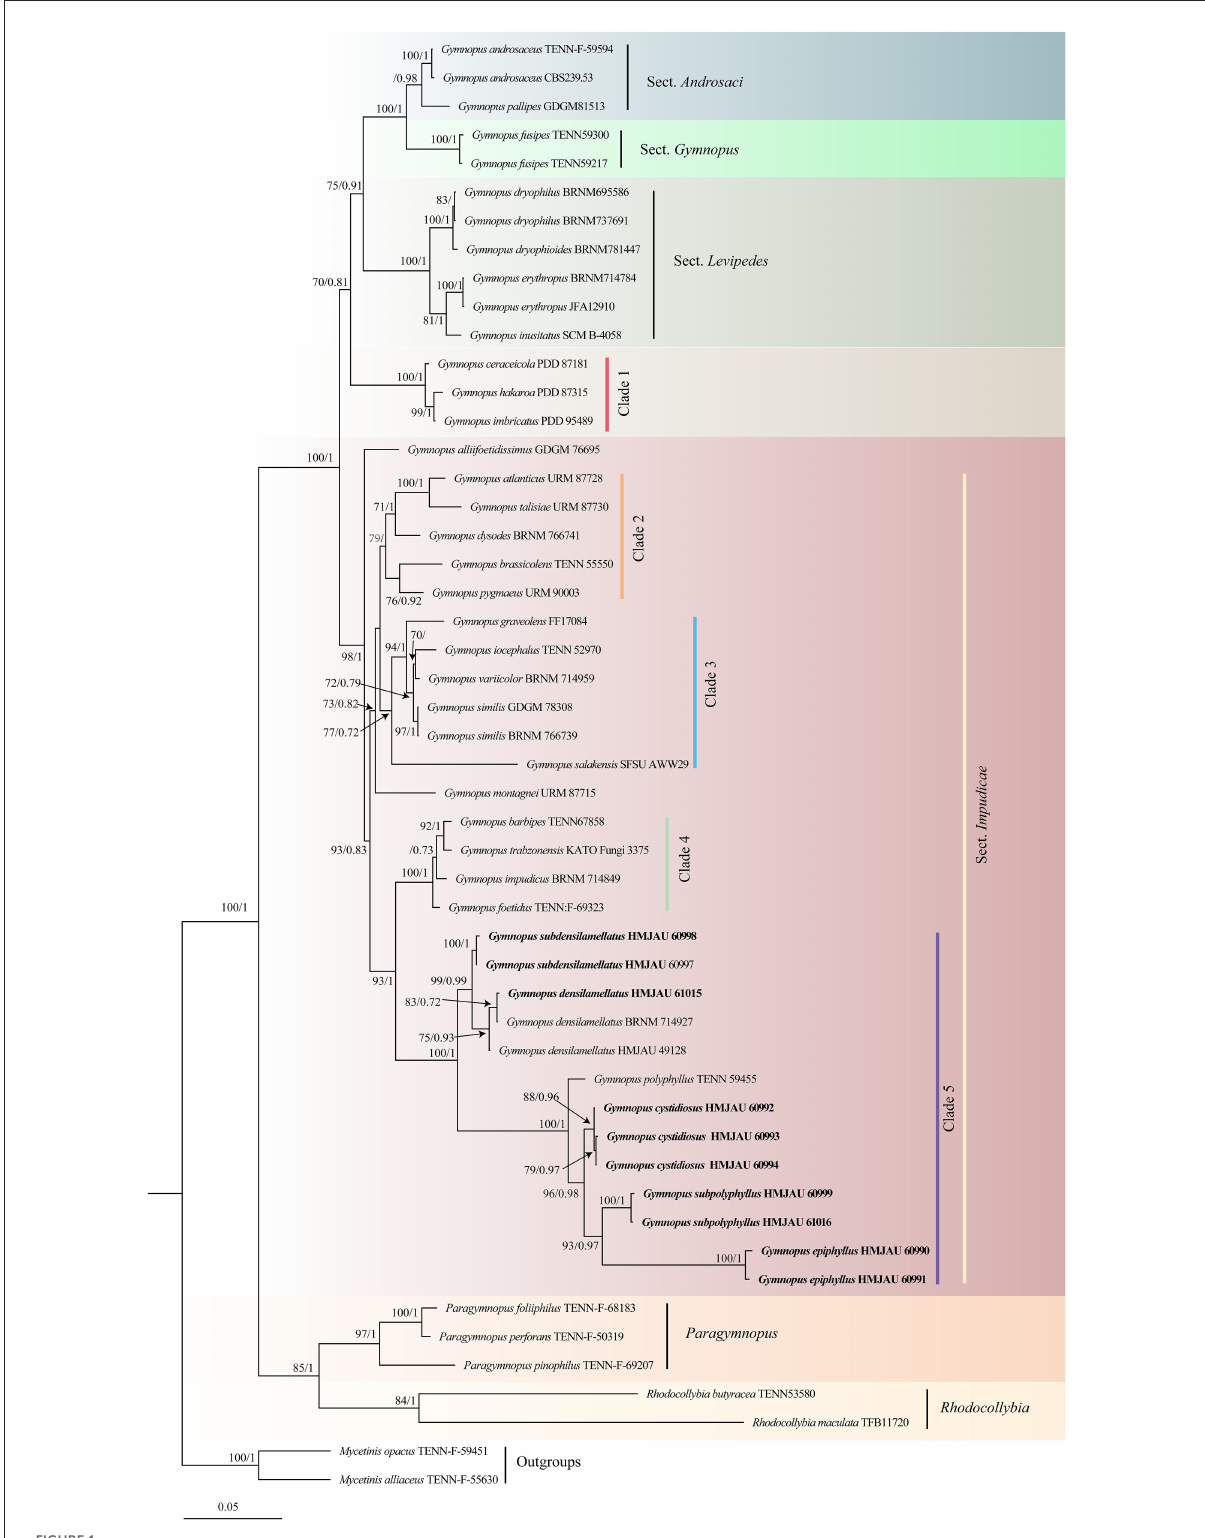
FIGURE1 Maximum likelihood phylogenetic tree generated from the ITS and nLSU dataset for the studied Gymnopus species and related genera. Two sequences of Mycetinis species are selected as outgroups. Bootstrap values (BS) ≥ 70% from ML analysis and Bayesian posterior probabilities (BPPS) ≥ 0.70 are shown on the branches. Newly sequenced collections are indicated in